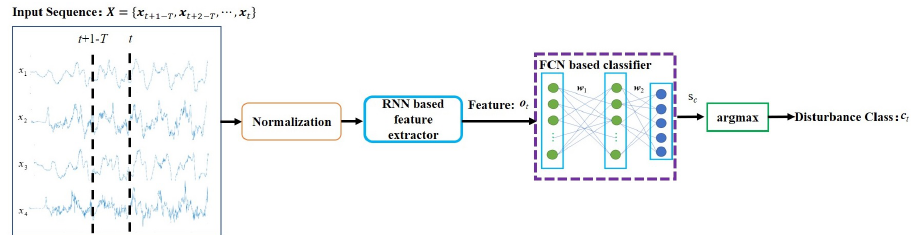
Figure 3. Pipeline of deep learning based disturbance